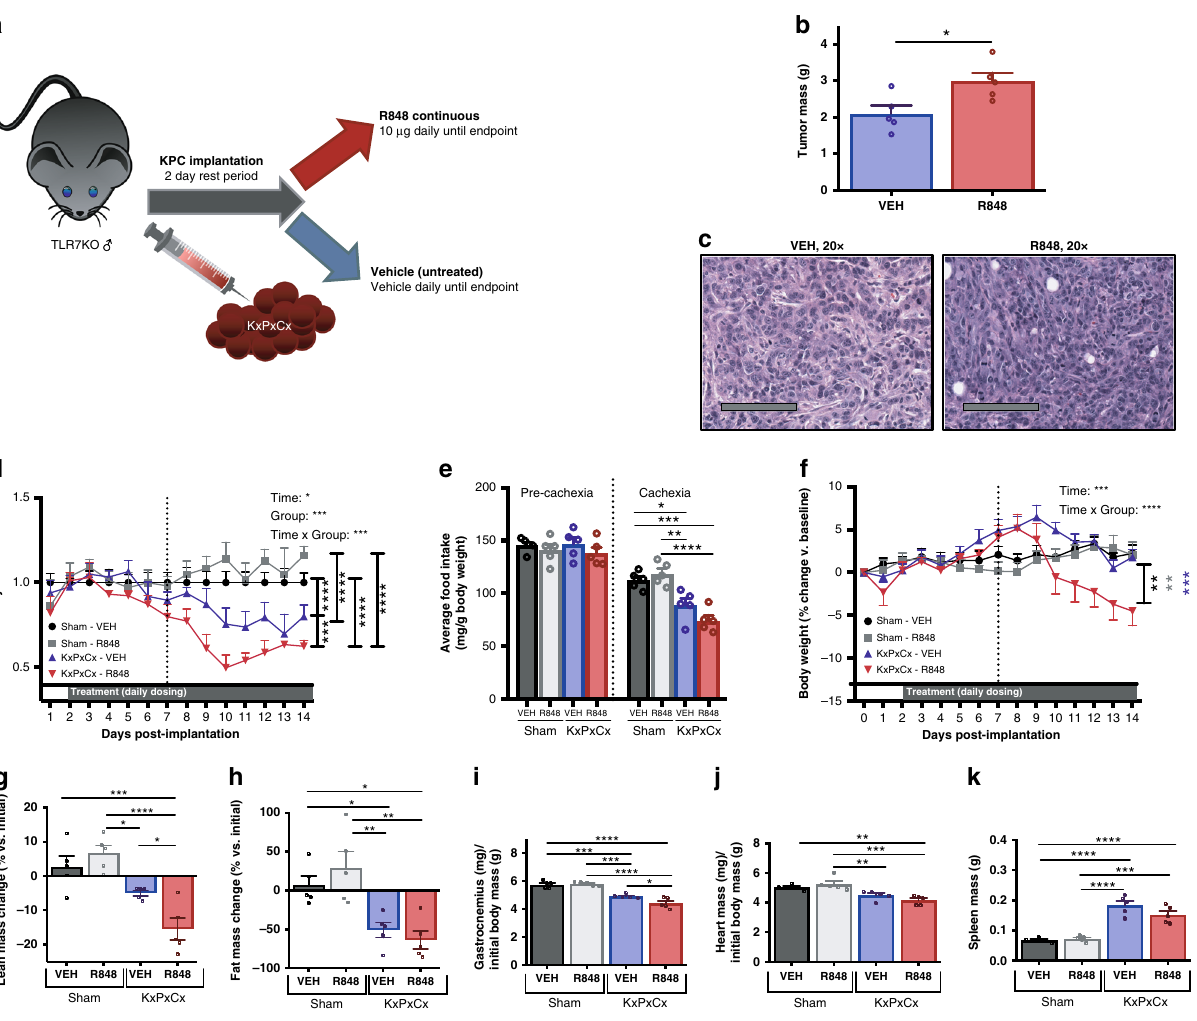
Fig. 6 The anti-tumor and cachexia attenuating effects of R848 require stromal TLR7. Male TLR7 hemizygous null (TLR7KO) mice were implanted with TLR7 intact KxPxCx, then randomized to R848 or vehicle as previously described ( a ). Tumor size ( b ) was increased following R848 in this context, with representative histology shown in ( d ). Food intake (plotted as a function of time in d and as cumulative averages in e ) and body weight ( f ) were both more severely affected during cachexia stage R848 treatment when TLR7 was absent in host tissues but present in neoplastic cells. This was accompanied by lean mass loss ( g ), no further changes in adipose wasting ( h ), skeletal muscle catabolism ( i ), cardiac muscle catabolism ( j ), and lack of splenic response to treatment ( k ). Statistical analyses were performed using two-way ANOVA during the cachexia stage to test for main effects of tumor and treatment, and the interaction thereof, with multiple-comparisons tests for main column effects. Values represent mean ± SEM. * P < 0.05; ** P < 0.01; *** P < 0.001; **** P <